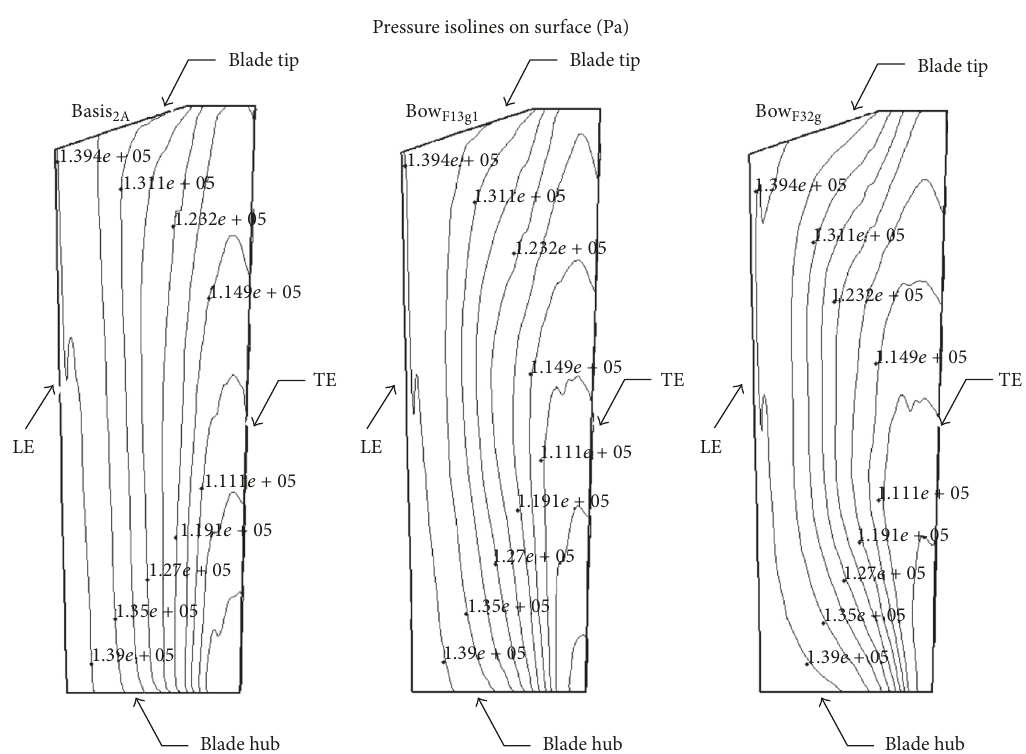
Figure 10: Pressure distributions on the suction side of the blade surface, where the unit of the pressure isolines on the blade surface is in Pascal. Therefore, LE and TE denote the leading edge and the trailing edge, respectively.